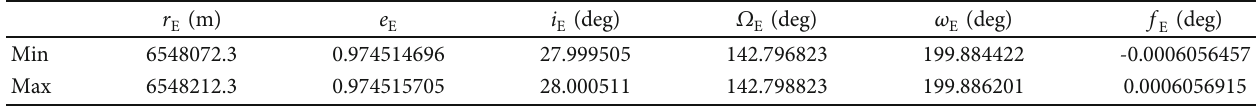
Table 9: The range of orbital elements values.